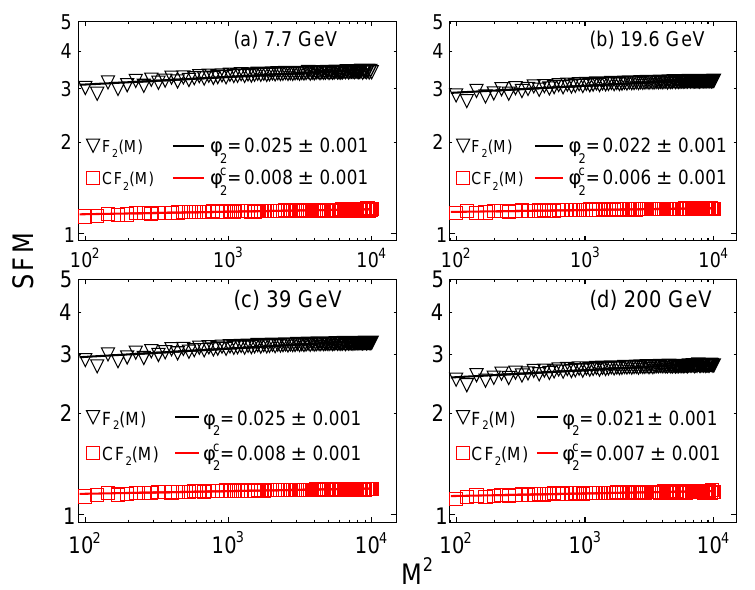
( M ) as a function of M 2 in Au + Au collision from the UrQMD model. Figure 1: F 2 The red symbols represent the SFMs calculated by the cumulative variable method.